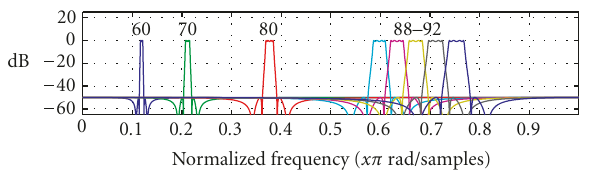
Figure 4: Magnitude responses in dB for the elliptic filters corre- sponding to the MIDI notes 60, 70, 80, and 88 to 92 with respect to the sampling rate of 4410